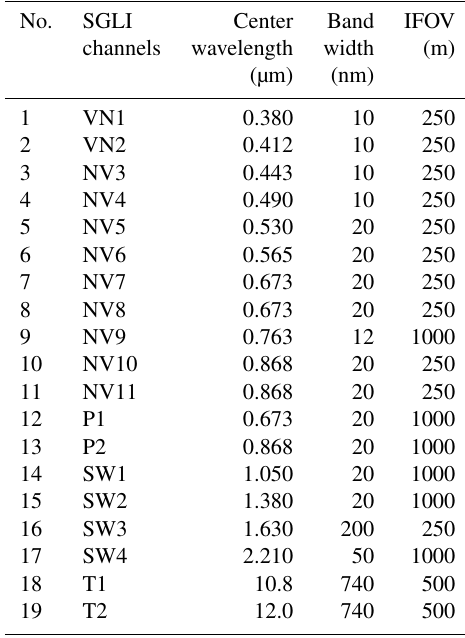
Table 1. Specification of the